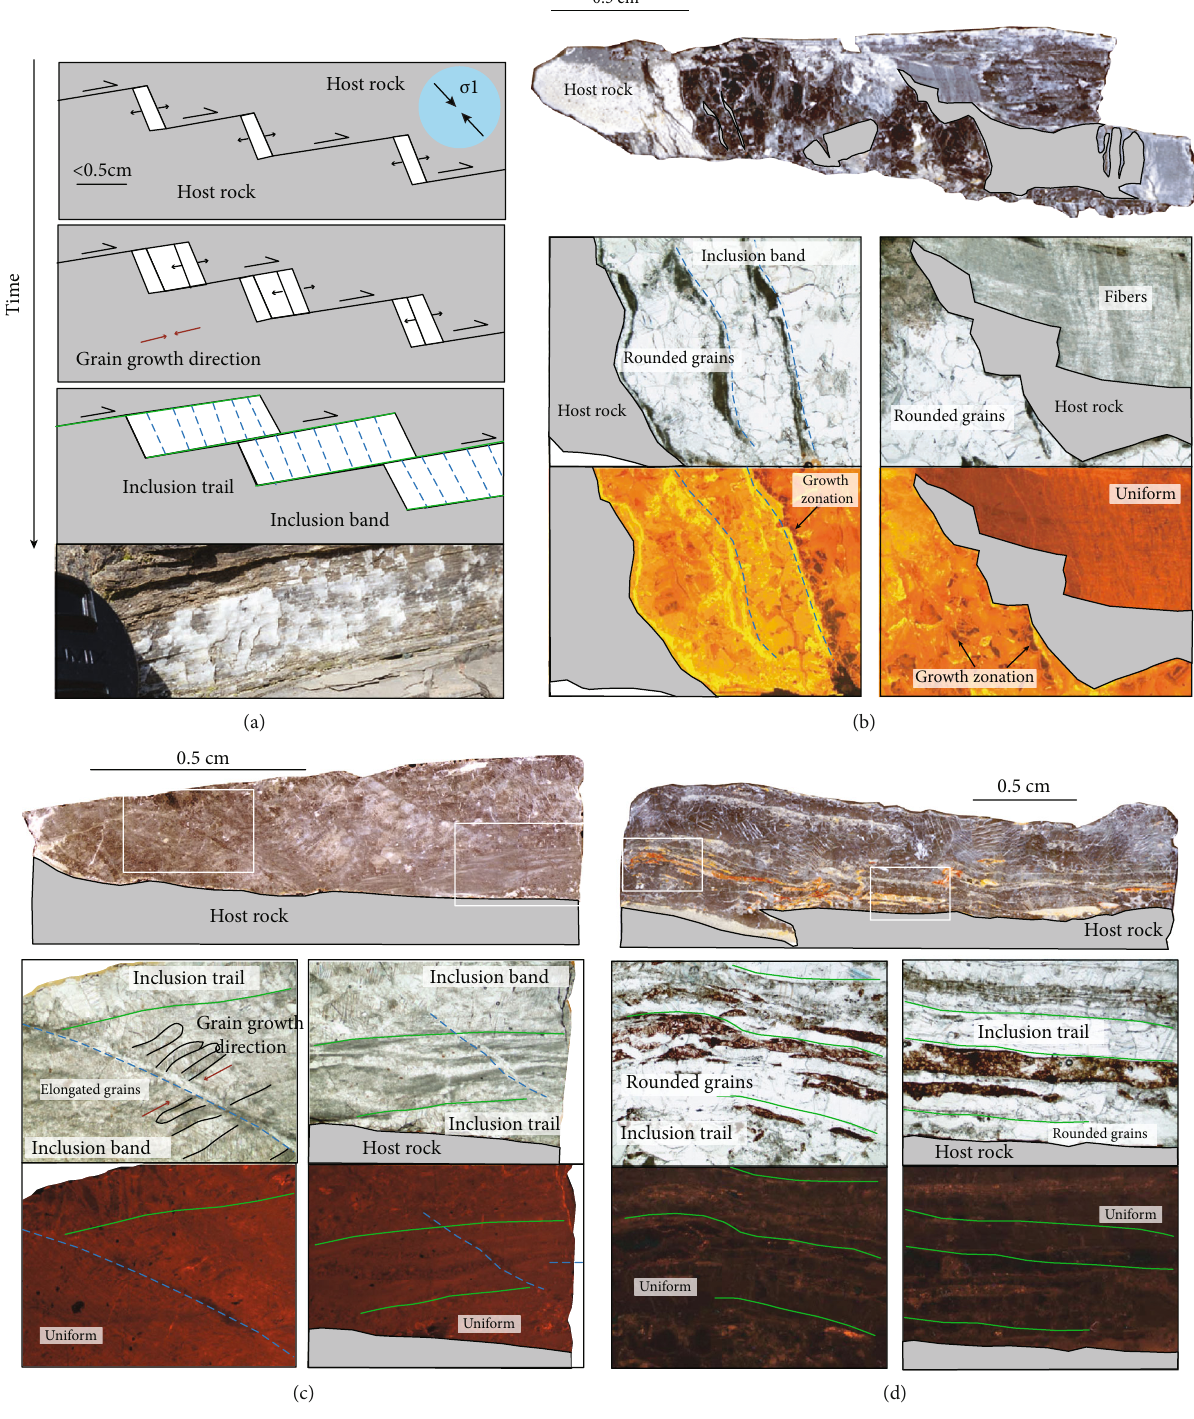
Figure 7: Petrography of the fault-related calcites (slicken fi bre calcite). (a) Sketch of the slicken fi bre calcite growth over time. Modi fi ed from Fagereng et al. [83]. The orientation of σ 1 is associated with the set of fi gures (a – d). (b) Petrography of CA18J04-3 sample. This calcite sample comes from a strike-slip fault (site 11, Figure 2) and could not be dated. Its texture is both fi brous — with a medium and uniform degree of luminescence — and granular — with the presence of growth zonations and a relatively high degree of luminescence. The inclusion bands indicate the syntectonic nature of the sample. (c) Petrography of CA18J06-1 sample (reverse fault-related calcite, Table 2). Under cathodoluminescence, calcite is uniform with a medium degree of luminescence. The presence of inclusion bands, inclusion trails, and elongated grains indicate the syntectonic nature of the sample. (d) Petrography of CA18J05-1 sample (reverse fault-related calcite, Table 2). Its texture is granular with the presence of inclusion trails, and the degree of luminescence is relatively low and